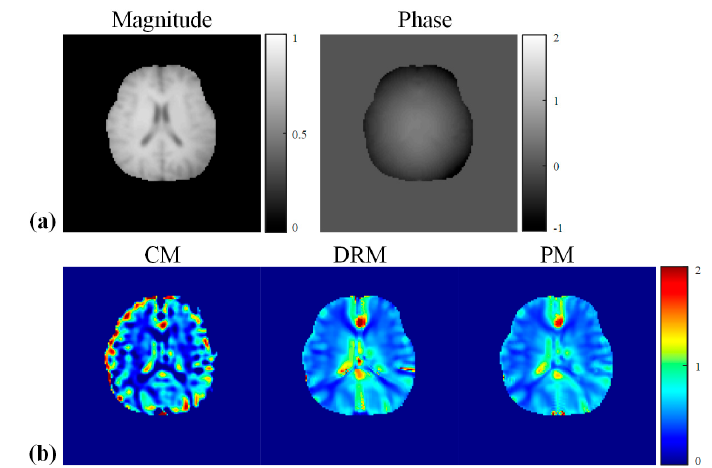
Figure 10. Magnitude, phase, and reconstructed conductivity images of head experiment. ( a ) Spin-echo (SE) magnitude and phase images; the SNR of the magnitude image is 75. ( b ) Conductivity images using the conventional method (CM), the double regularization method (DRM), and the proposed method